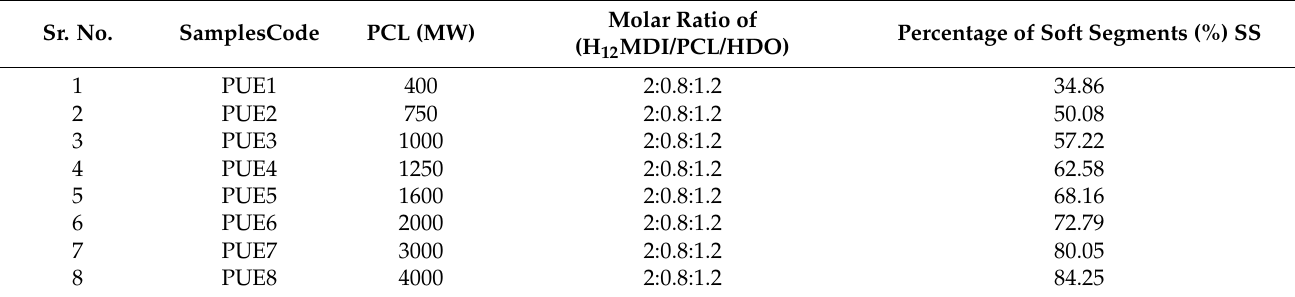
Table 1. Sample codes, PCL molecular weight and the molar ratio of reactants in a series of molecular weight-based PUE samples.